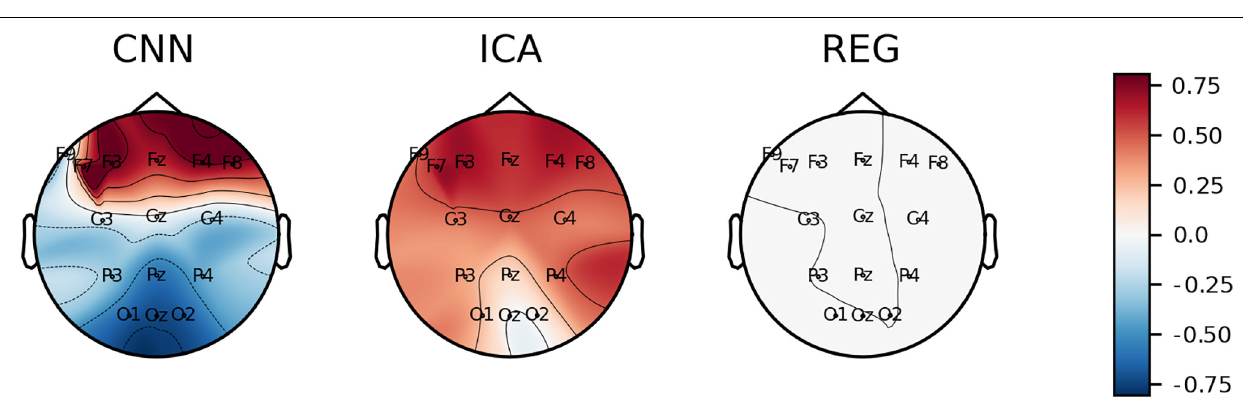
FIGURE 10 | The average value of C kk coefficient plotted on the head surface.